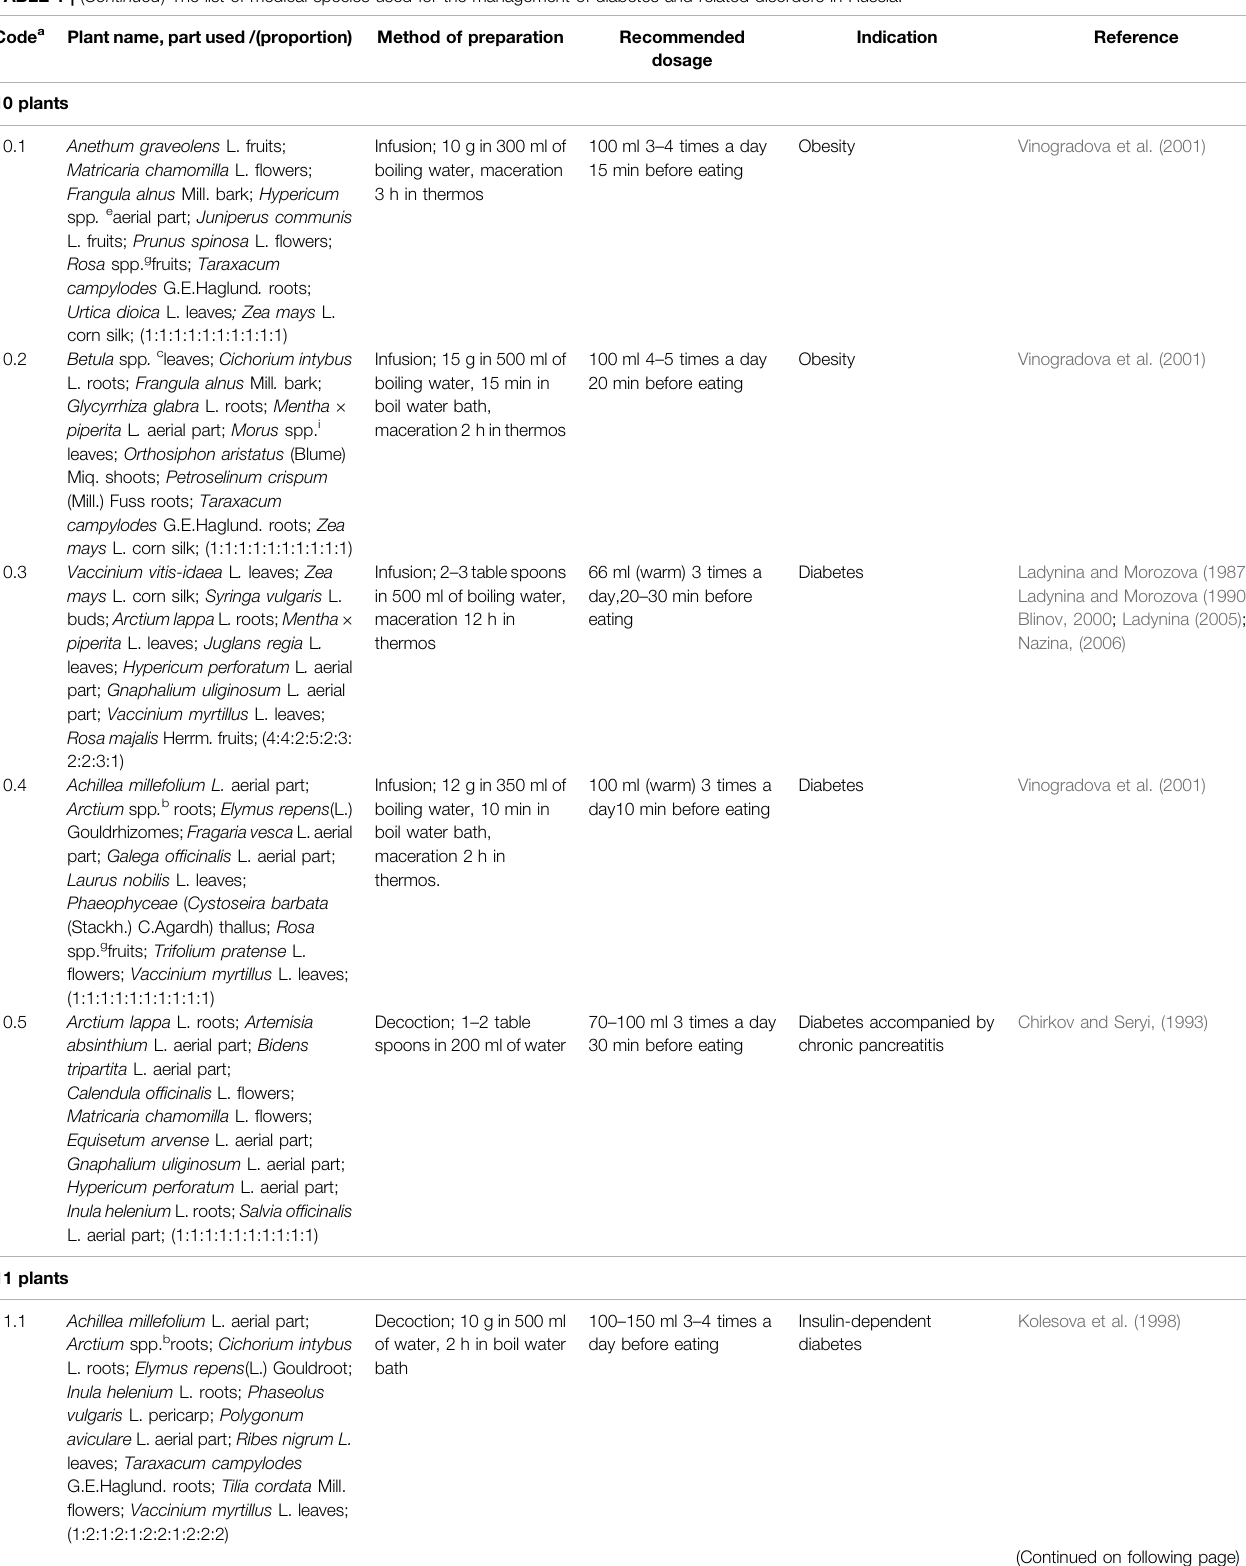
TABLE 1 | ( Continued ) The list of medical species used for the management of diabetes and related disorders in Russia. Code a Plant name, part used /(proportion) Method of